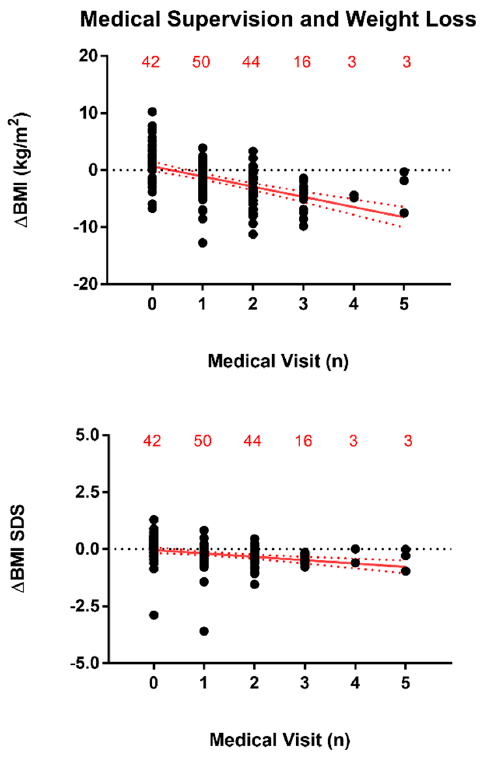
Figure 1. Linear regression (for all data, mean ± 95% confidence interval, CI) of weight loss ( Δ BMI– top panel–or Δ BMI-SDS–bottom panel–, i.e., [BMI T2 –BMI T1 ] or [BMI-SDS T2 –BMI-SDS T1 ]) as dependent variable (y) with medical supervision (i.e., number of any kind of medical visit occurred in-between the BWRPs at T1 and T2) as independent variable (x). For Δ BMI: y = − 1.785 × x + 0.6801 (r 2 = 0.2678 and p < 0.0001). For Δ BMI SDS: y = − 0.1476 × x–0.04101 (r 2 = 0.09292 and p < 0.0001). Note: the number of obese subjects for each set of medical visits (0–5) are reported at the top of the two panels. Table 1. Linear regression of changes in auxometric and metabolic parameters in the entire population of children and adolescents with obesity, being ∆ BMI the independent